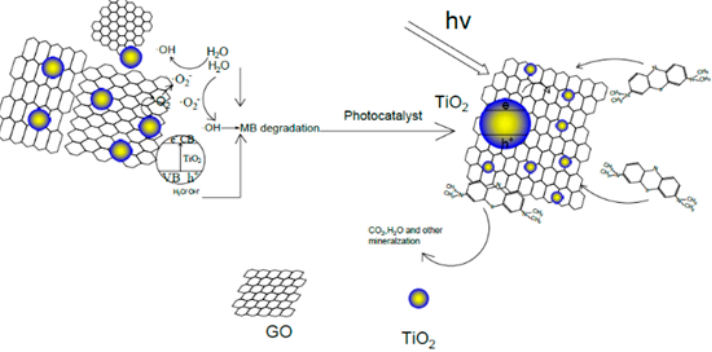
Figure 9. Illustration of the GO supported TiO 2 for the